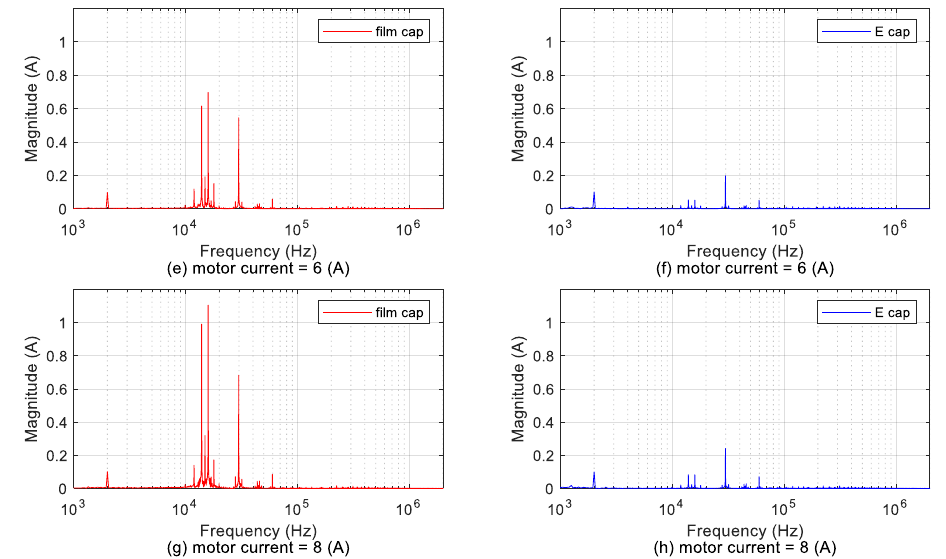
Figure 18. Frequency spectra of the capacitor current as functions of frequency at the motor speed of 5000 rpm.